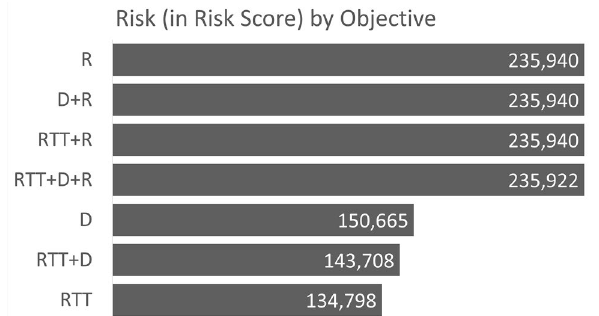
Figure 3. Bar chart representing the risk measure broken down by